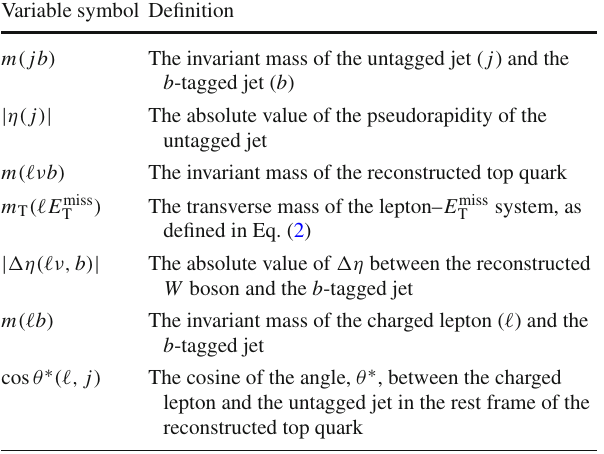
Table 2 The seven input variables to the NN ordered by their discrim- inating power. The jet that is not b -tagged is referred to as untagged jet Variable symbol